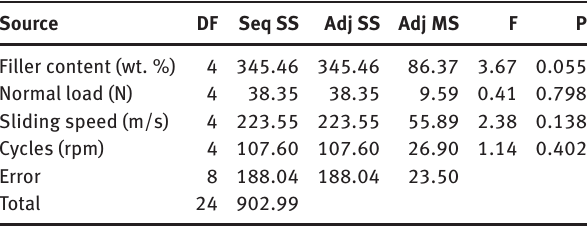
Table 7: ANOVA table for specific wear volume of nanoalumina- filled dental composite.